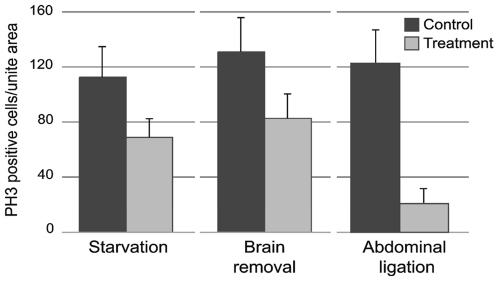
Quantification of cell proliferation in the forewing imaginal disk.Cell proliferation was measured as the average number of PH3 positive cells in an area of 0.0875mm2 of the wing imaginal disk. Effect of starvation: larvae were starved on day 4 of the feeding phase and PH3 cells in the wing disk were counted 48h later (p = 0.021). Effect of brain removal: the brain was removed the first day of the wandering phase (day 6) and PH3 cells were counted 24h later (p<0.001). Effect of abdominal ligation: a ligation was placed between the thorax and the abdomen on day 6 larvae, and PH3 cells were counted 24h later (p<0.001). Each bar represents the mean of 10 disks. Error bars SEM.